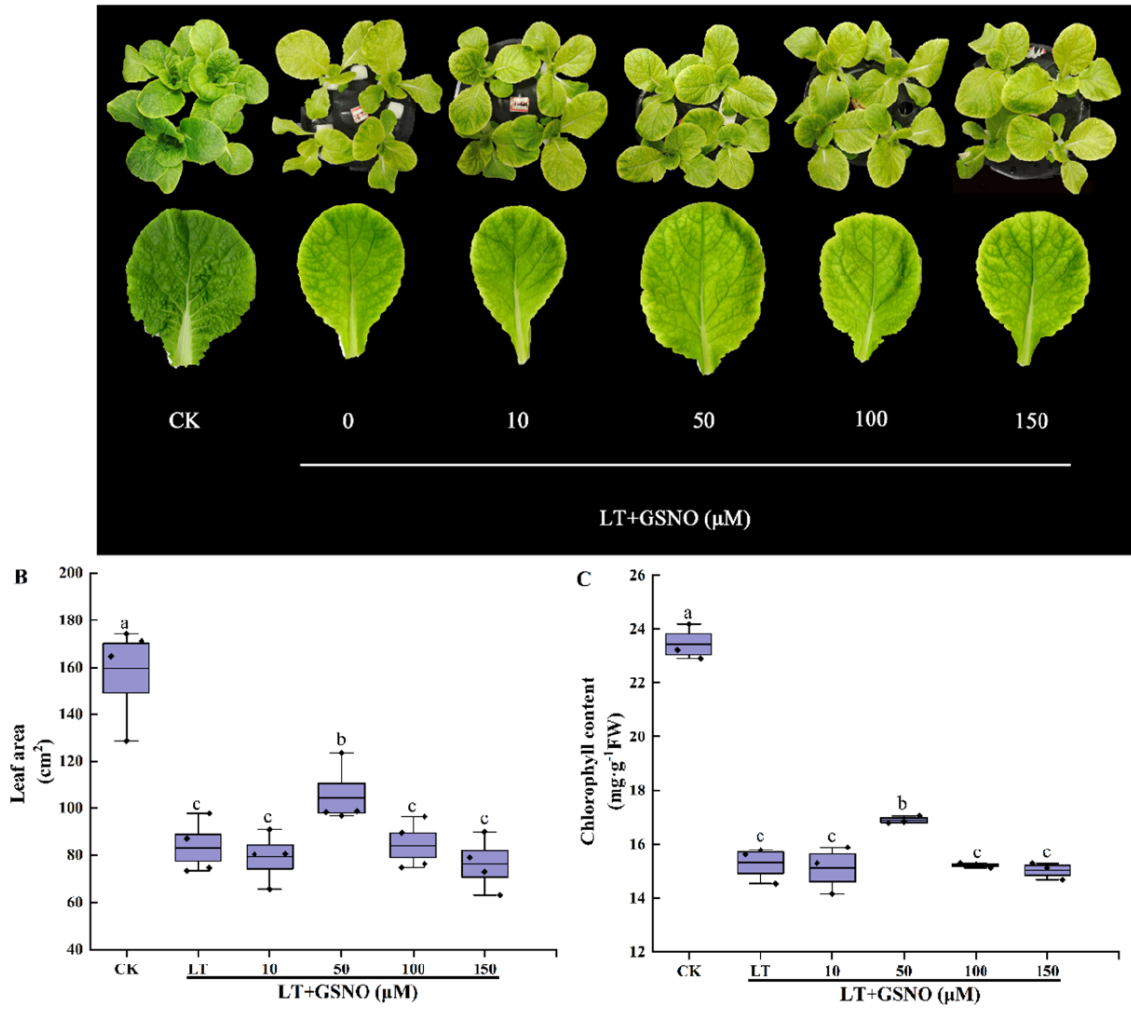
Figure 2. The effects of different concentrations of GSNO on the phenotype, leaf area, chlorophyll content, MDA and proline content of mini Chinese cabbage under low temperature stress. Five-leaf seedlings were treated with CK (26/18 °C, day/night), LT (4/4 °C, day/night) and different concen- trations of GSNO (0, 10, 50, 100 and 150 µM) under low-temperature stress. The leaves were sprayed with GSNO once a day for 3 d and treated for 7 d. After 7 d, leaf area, chlorophyll content, MDA and proline contents were measured, respectively. ( A ) Phenotype and leaf size of the third leaf from outside to inside after treating for 7 d; ( B ) Leaf area of the third leaf from outside to inside; ( C ) Chlorophyll content; ( D ) MDA content; ( E ) Proline content. Different lowercase letters above the error bars indicate significant differences at the 0.05 level ( p ≤ 0.05).